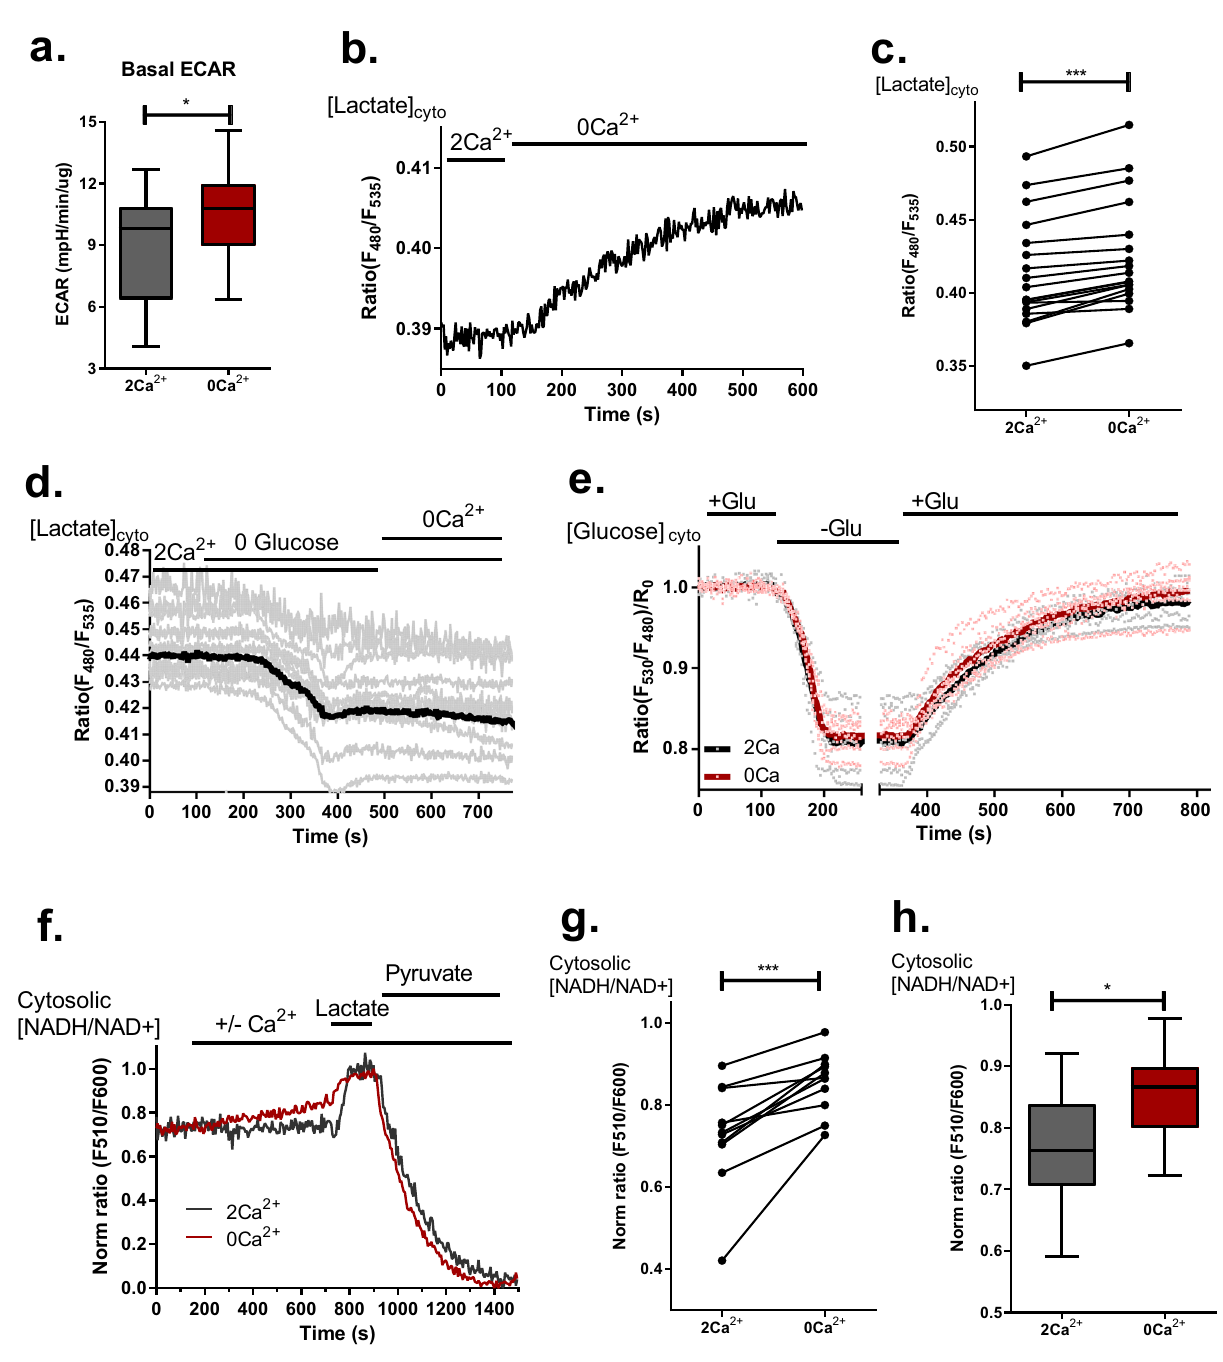
Fig. 4 ECAR, cytosolic lactate and NADH/NAD + ratio increase in response to Ca 2 + deprivation. a Statistical analysis of ECAR (unpaired t -test, n = 17 for 2 Ca 2 + , n = 25 for 0 Ca 2 + ; * p = 0.0414). b Representative trace of cytosolic lactate accumulation measured with Laconic after perfusion with 0 Ca 2 + buffer. c Statistical analysis of cytosolic lactate levels before and after 6 min of Ca 2 + removal (paired t -test, n = 18; *** p < 0.0001). d Average trace (solid black line) and single cell traces (grey lines) of cytosolic lactate measurements with glucose removal ( n = 12). e Average traces (solid lines) and single data points of cytosolic glucose measurements using FLII12Pglu-700 μδ 6 with glucose removal and re-addition ( n = 5 for 2 Ca 2 + , n = 6 for 0 Ca 2 + ). f Representative traces of cytosolic NADH/NAD + measurements with Peredox and subsequent calibration with 10 mM lactate and pyruvate. g Statistical analysis of cytosolic NADH/NAD + ratio of cells before and after 6 min of Ca 2 + removal (paired t -test, n = 11; *** p = 0.0003). h Comparison of cytosolic NADH/NAD + ratio after 6 min in 2 Ca 2 + or 0 Ca 2 + buffer (unpaired t -test, n = 9 for 2 Ca 2 + , n = 11 for 0 Ca 2 + ; * p =